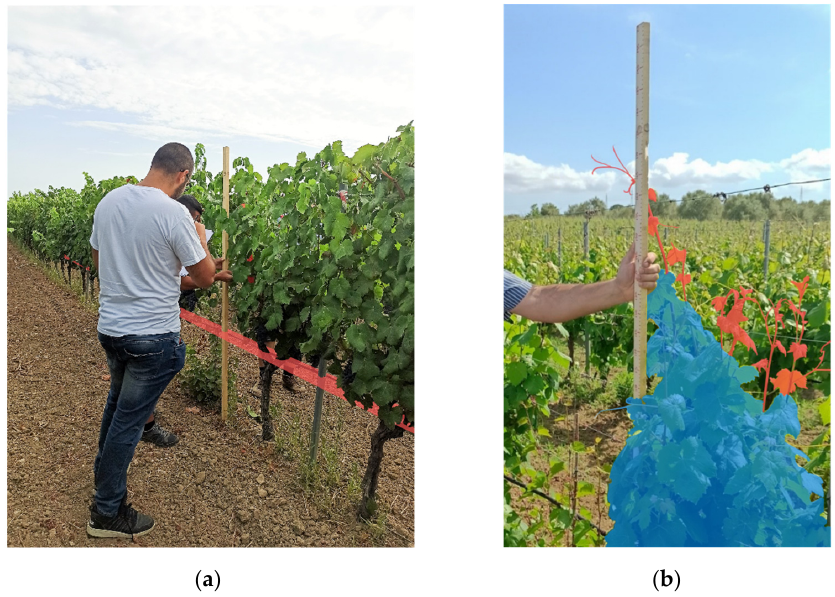
Figure 2. ( a ) The measurements of height and width rows using the wooden rod. Canopy heights were calculated subtracting 0.90 m (red line) from the total measure; ( b ) an exemplification of the influence of isolated shoots (in red) in height and width determination during field measurements. The blue shape represents the volume estimated in 2017 and 2019, excluding the shoots out of the row’s shape considered in 2016.